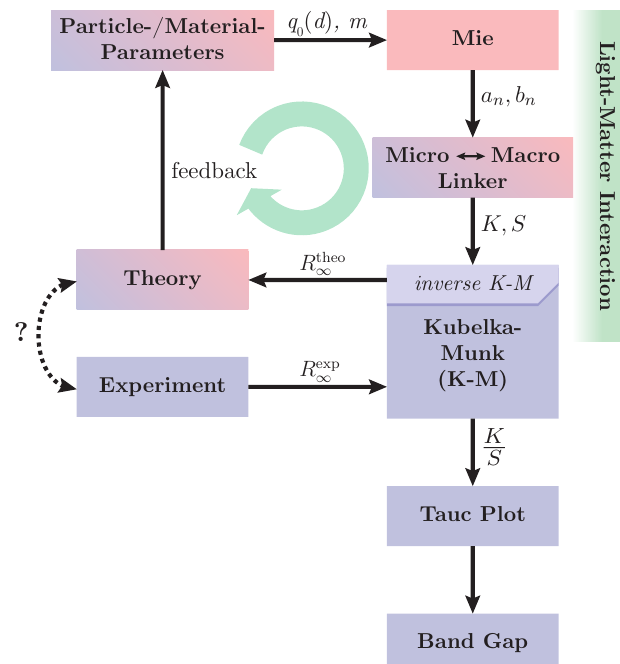
Figure 14. Flow chart illustrating the connections between experiment and theory. Macroscopic views are shaded in blue whereas microscopic ones are red. The process from Mie theory towards calculation of R theo